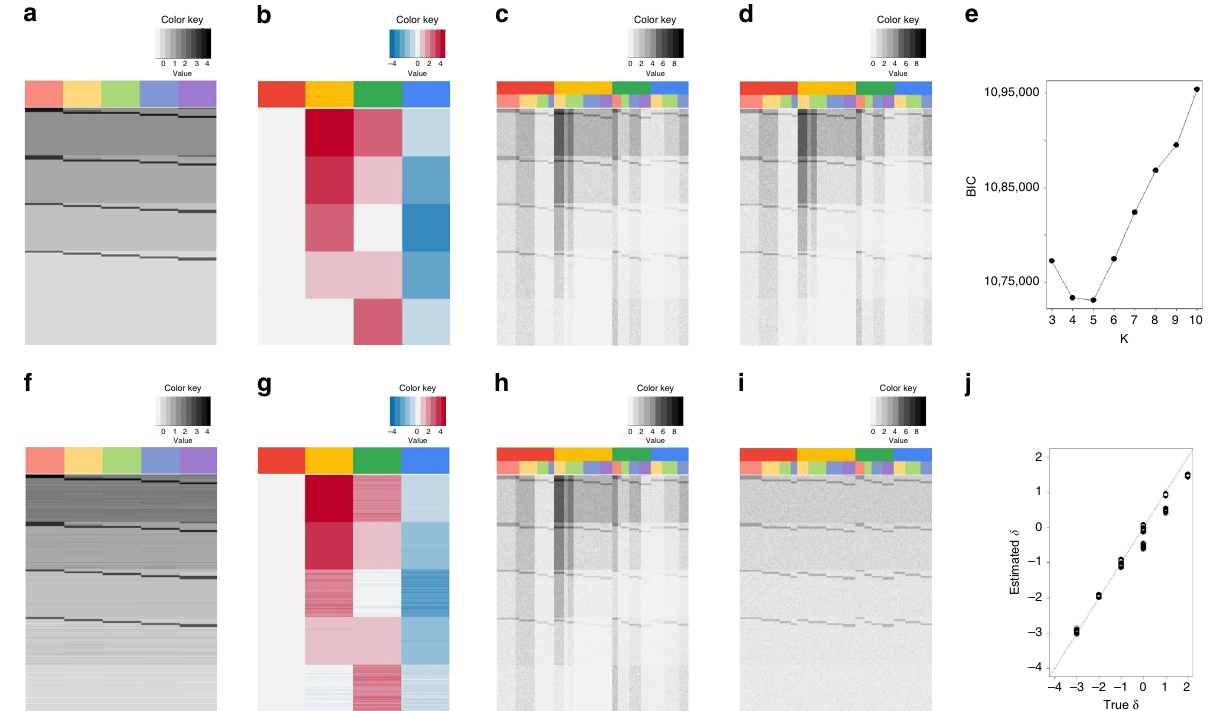
Fig. 2 Patterns of the simulation study. a True log-scale mean expression levels for each cell type α + β . Each row represents a gene, and each column corresponds to a cell type. The intrinsic genes that are differentially expressed between cell types can have high, medium high, median low or low expression levels. b True batch effects. Each row represents a gene, and each column corresponds to a batch. c True underlying expression levels X . Each row represents a gene, and each column corresponds to a cell. The upper color bar indicates the batches, and the lower color bar represents the cell types. There are a total of 3000 genes. The sample sizes for each batch are 300, 300, 200, and 200, respectively. d The simulated observed data Y . The overall dropout rate is 27.3%, whereas the overall zero rate is 50.8%. e The BIC plot. The BIC attains the minimum at K = 5, identifying the true cell type number. f The estimated log-scale mean expression levels for each cell type b α þ b β . g Estimated batch effects. h Imputed expression levels b X . i Corrected count data e X grouped by batches. j Scatter plot of the estimated versus the true cell-speci fi c size